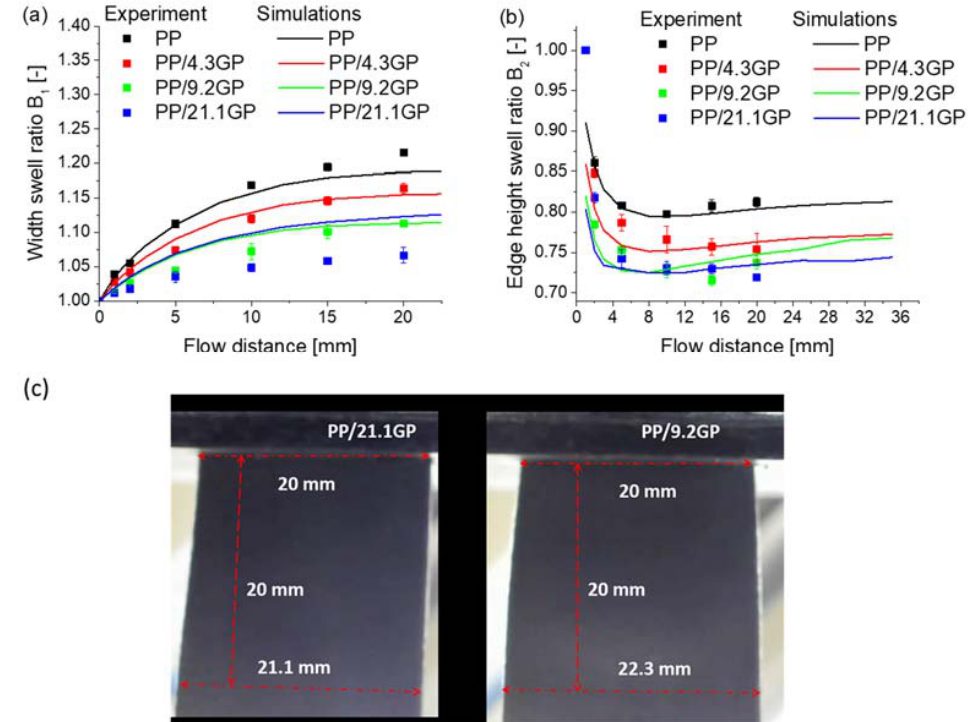
Figure 7. Comparison between the evolution of the simulated (lines) and experimental (symbols) swelling data for PP melts with various filler content, distinguishing in between the width swelling ratio B 1 ( a ) and the edge height swelling ratio B 2 ( b ). Note that experimental measurements were carried out at different flows rates since the extrusion speed has been fixed at 60 rpm: 620 mm 3 /s for neat PP, 552.63 mm 3 /s for PP/4.3GP composite, 510 mm 3 /s for PP/9.2GP composite, and 504.6 mm 3 /s for PP/21.1GP composite. Simulations always at 620 mm 3 /s. In addition in subfigure ( c ), images of the extrudate profiles of PP/21.1GP and PP/9.2GP.